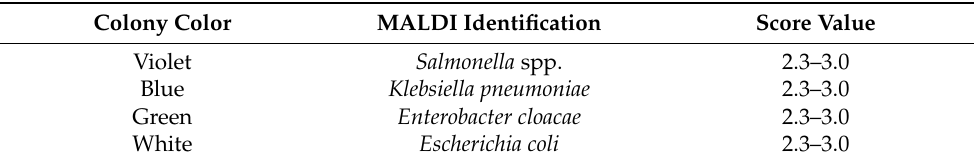
Table 2. MALDI-TOF-MS identification of the bacteria species found on RAPID Salmonella agar. Range of score values: 2.3–3.0: Highly probable species identification; 2.0–2.29: Secure genus identification and probable species identification; 1.7–1.99: Probable genus identification; 0.0–1.69: Non-reliable identification.